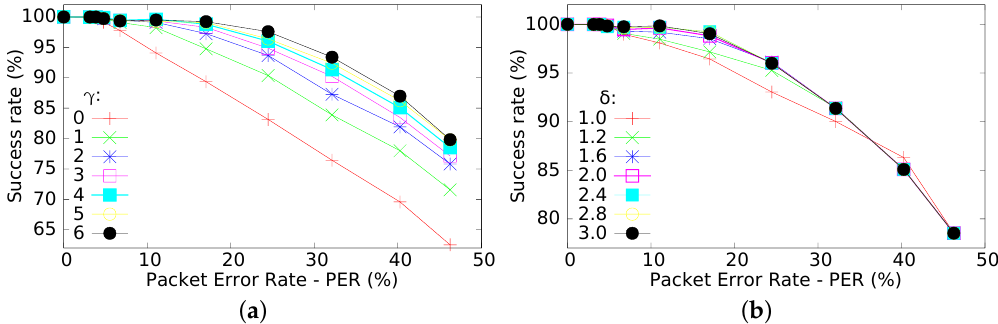
Figure 10. Tuning parameters. ( a ) Effects of varying γ parameter; ( b ) Effects of varying δ parameter.